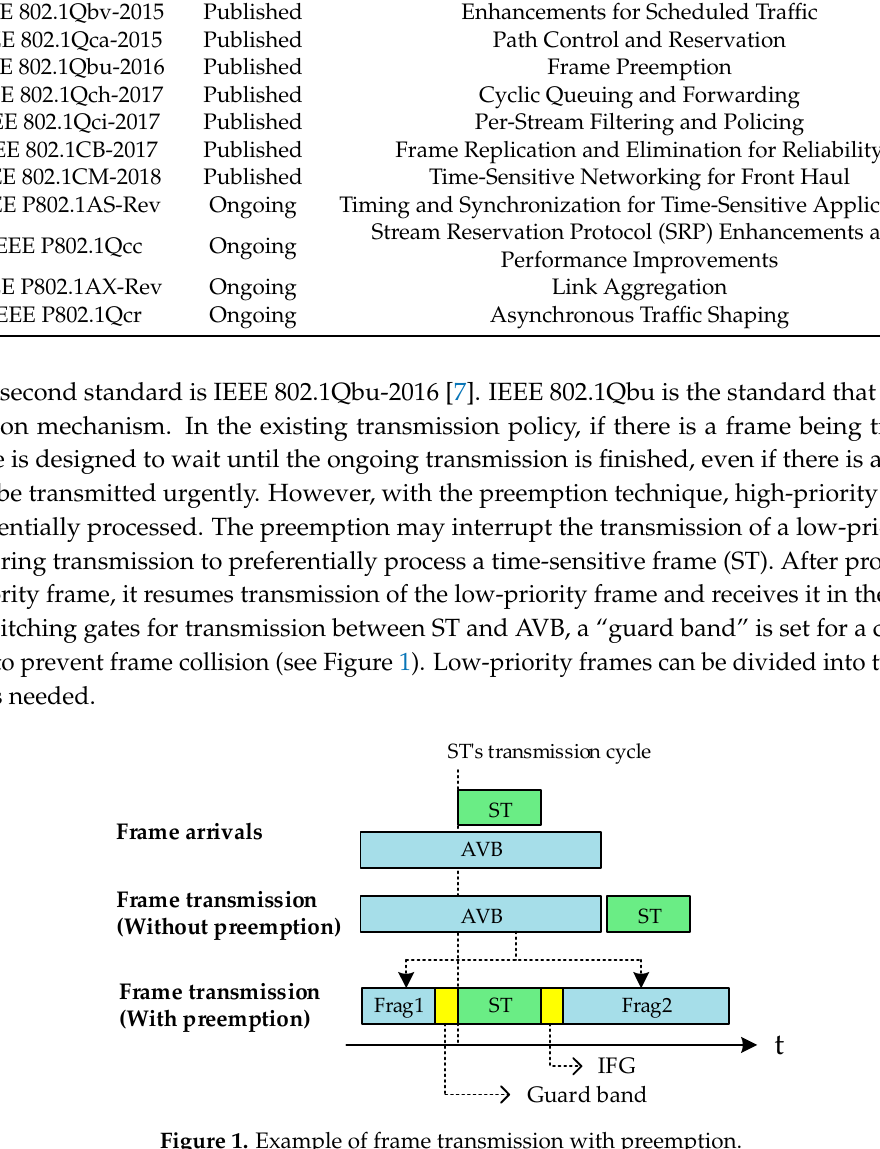
Figure 1 . Example of frame transmission with preemption. Figure 1. Example of frame transmission with